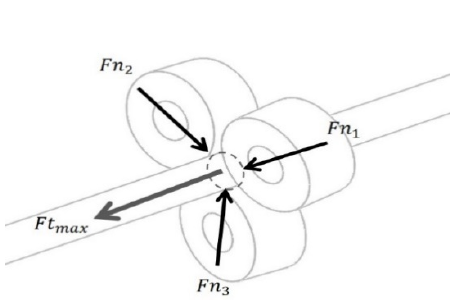
Figure 3. A simplified TLBS structure with normal forces and maximum output force.